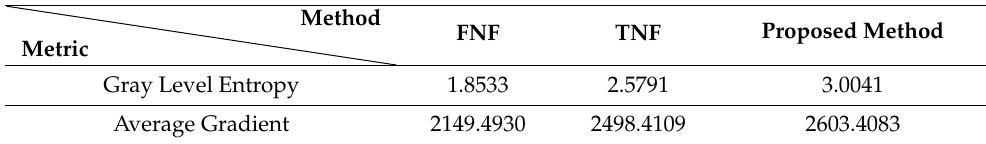
Table 3. Gray level entropies and average gradients after FNF, TNF, and the proposed method (single source).